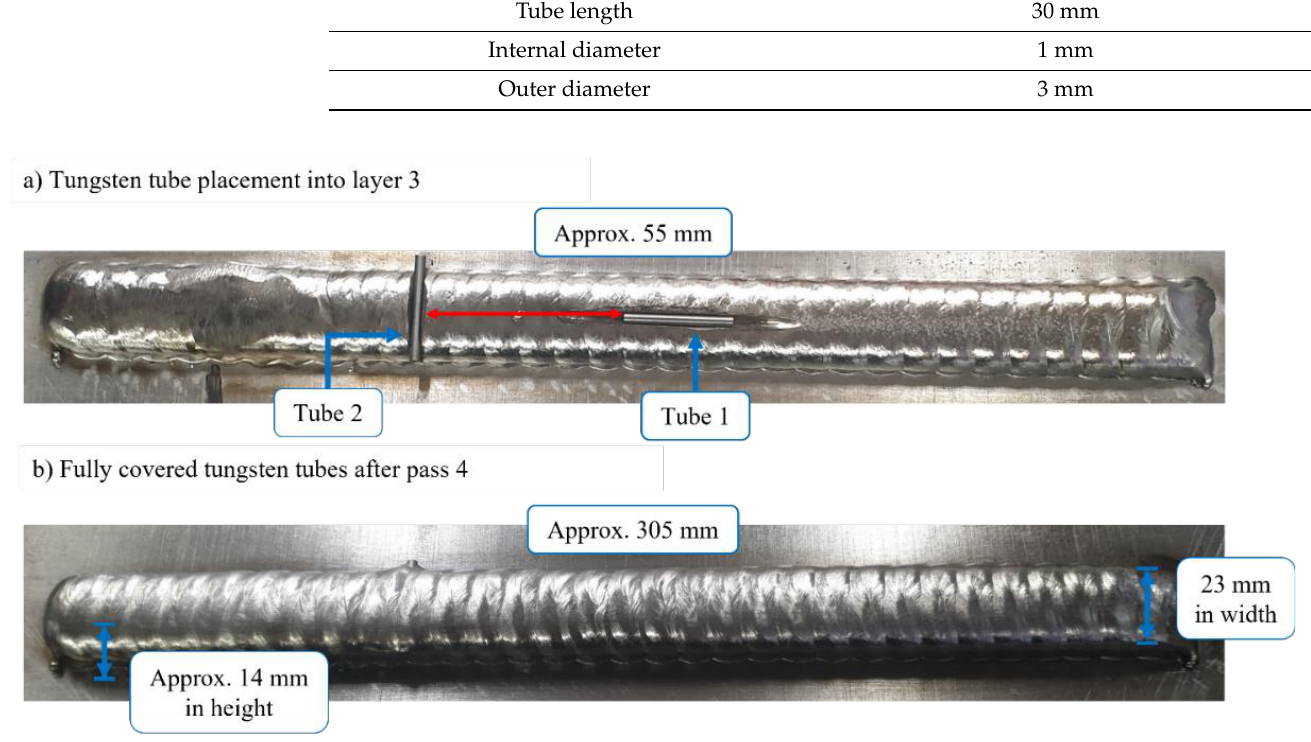
Figure 6. Tungsten tube embedding into layer 3 ( a ) and a subsequently deposited layer 4 covering tubes ( b ).